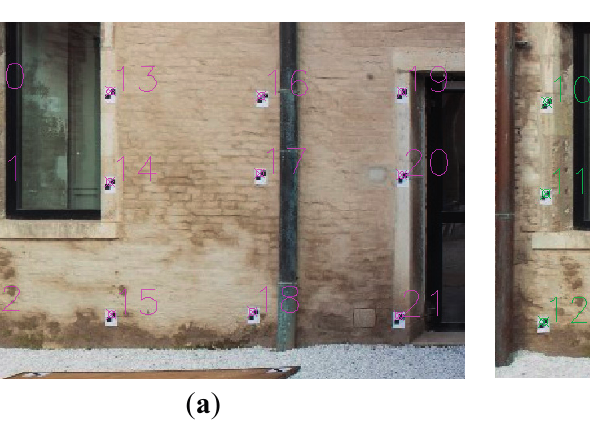
Figure 18. The rectification of the original ( a ) and undistorted NIKON D100 images; ( b ) lead to an RMS error of the collected GCPs of 0.0013 m and 0.0001 m using the VeCAD − Photogrammetry application